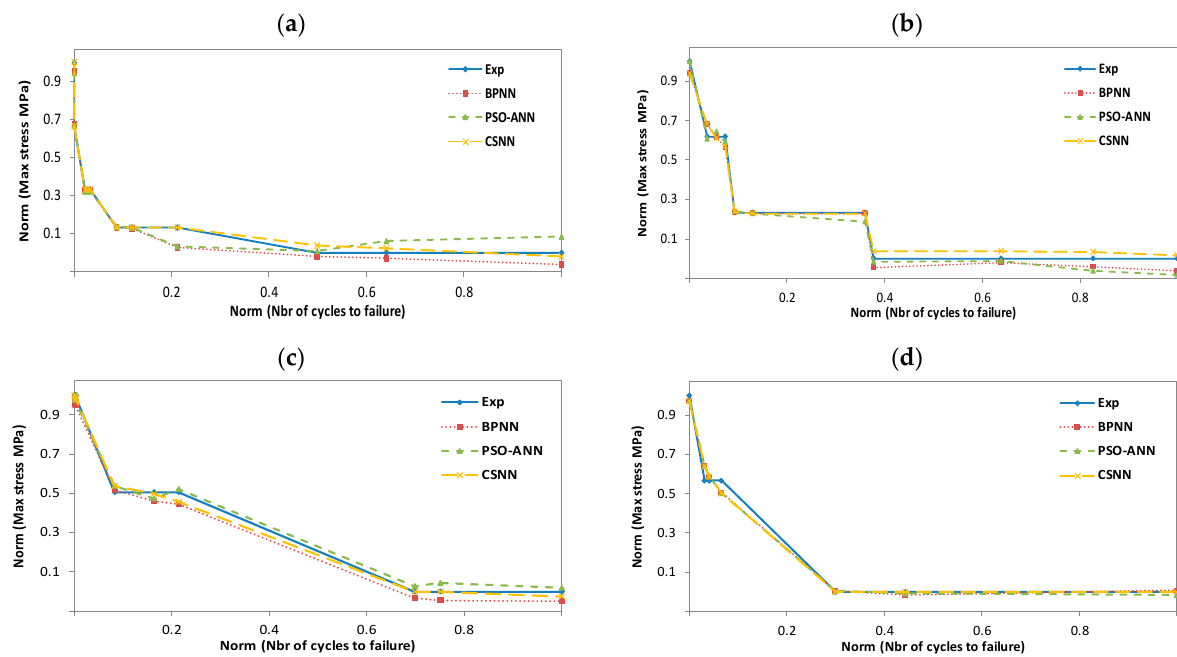
Figure 11. Experimental and predicted values of ortho-polyester resin fatigue life (CoRezyn 63-AX-051). ( a ): T = 50 °C wet; ( b ): T = 50 °C dry; ( c ): T = 20 °C wet; ( d ): T = 20 °C dry.